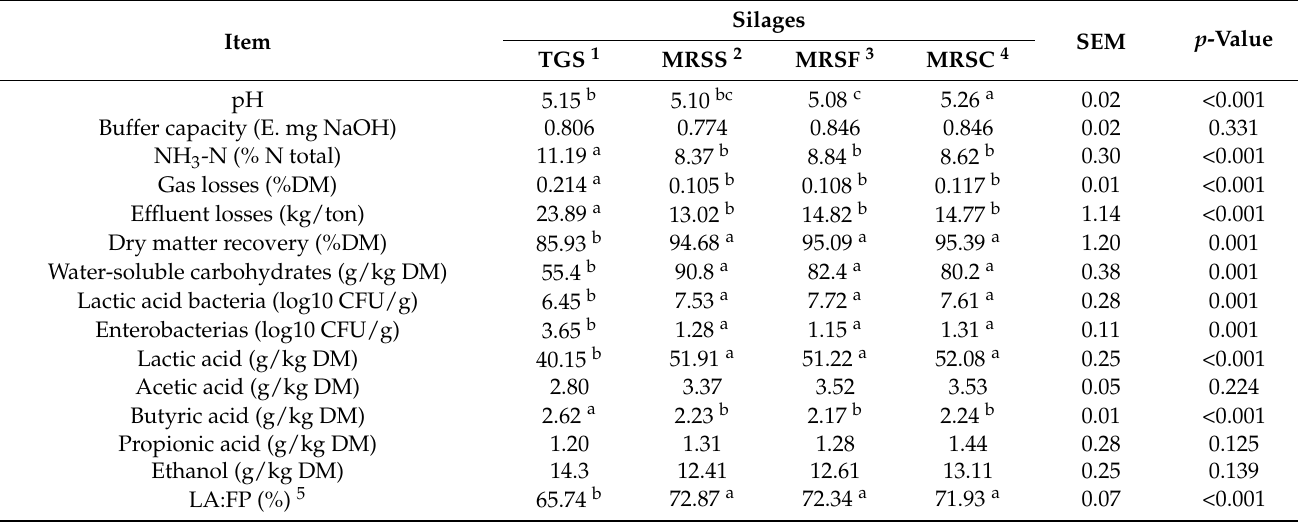
Table 3. Fermentation profile, losses and values of organic acids (%DM) of total ration silages with babassu